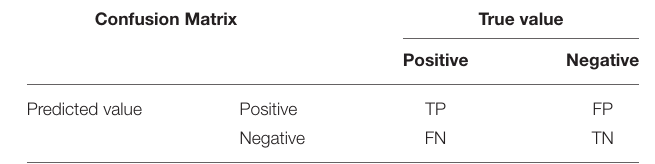
TABLE 4 | Confusion matrix.